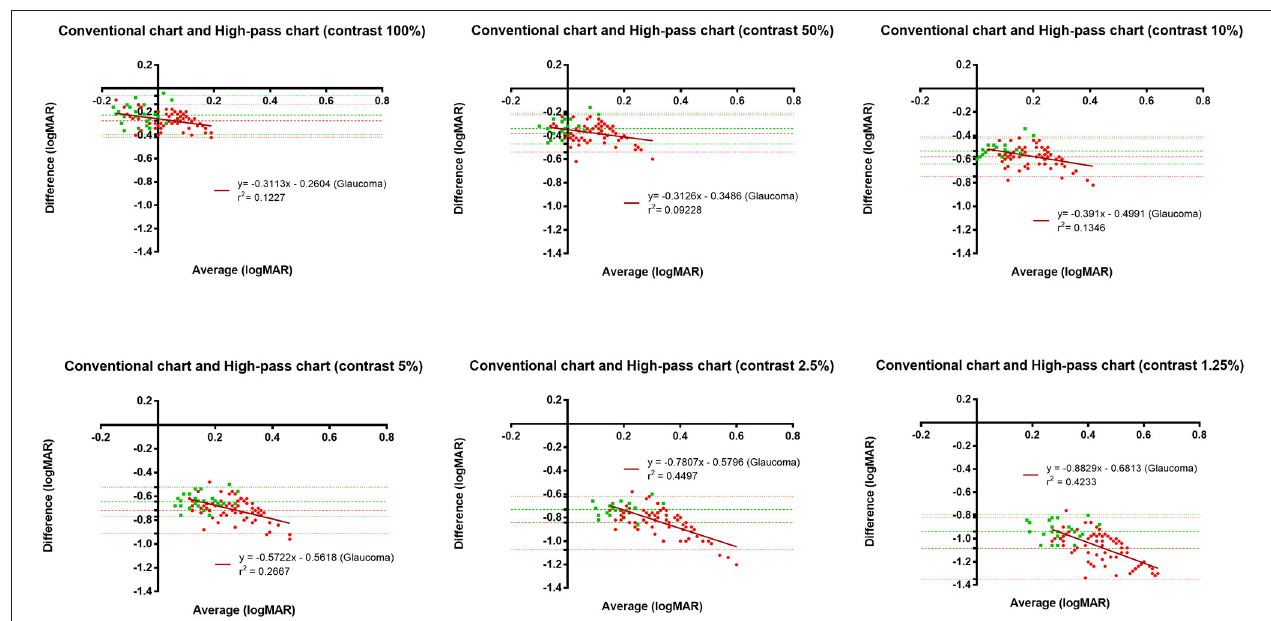
FIGURE 5 | Bland-Altman plots displaying the differences in VAs measured using the conventional chart and high-pass charts in glaucomatous eyes with normal vison ( n = 75) and healthy controls ( n = 29). The red dots represent data from glaucoma patients, whereas the green squares represent data for healthy controls. The horizontal lines represent the bias of the tests and 95% limits of agreement. The dark red lines represent the best linear fit to the data from glaucoma patients.